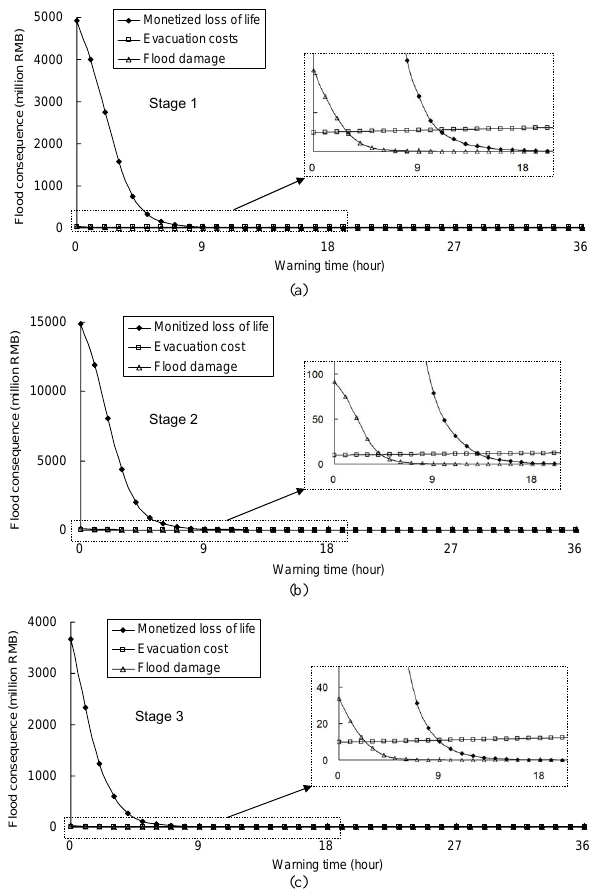
Fig. 13. Flood consequences in Beichuan Town: (a) stage 1; (b) stage 2; (c) stage 3.